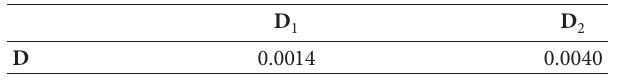
( i � 1 , 2 ) ; (c, e) the differences i Table 7: Decryption key sensitivity